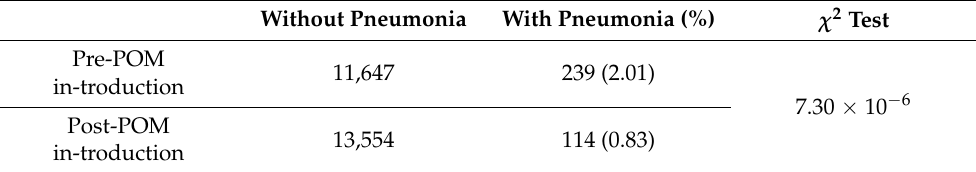
Table 5. Incidence rate of post-admission